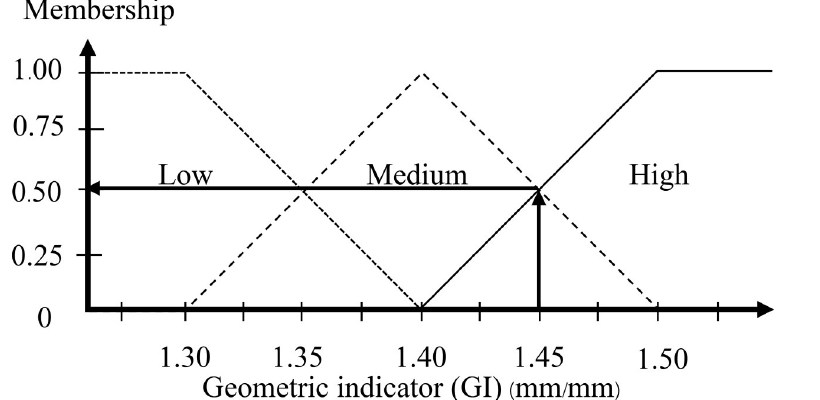
Based on the input memberships, nine cases ( R 1– R 9) of situations exist, and the fuzzy oper- ation for all rules is done. The probabilistic situation and method develops the subsequent resulting details: